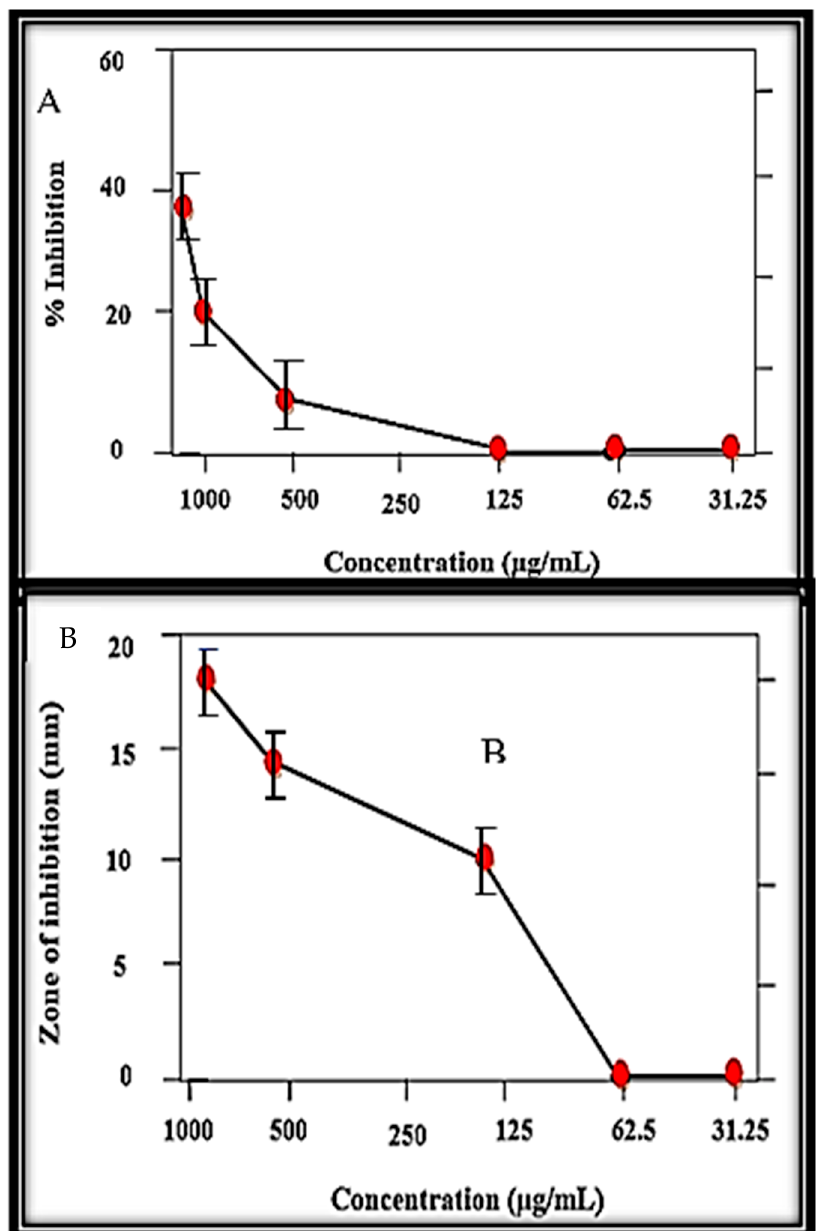
Figure 9. Inhibition potential of MB-ZnO nanocomposites against protein kinase ( A ) and alpha-amylase activities ( B ).